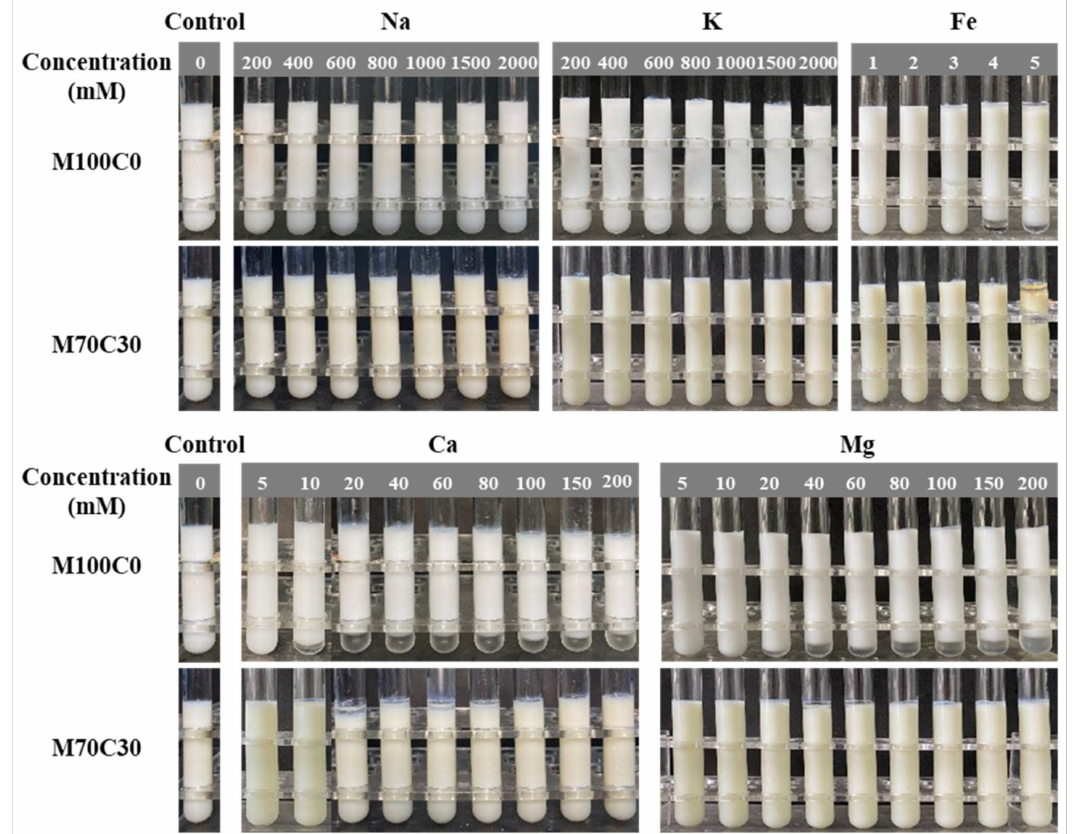
Figure 1. Appearance of WPI-stabilized emulsions in the absence and presence of CA at different ion types and strengths after 7 days’ storage. M100C0 represents that the oil phase is 100 wt% MCT. M70C30 represents that the oil phase is a mixture of 70 wt% MCT and 30 wt%